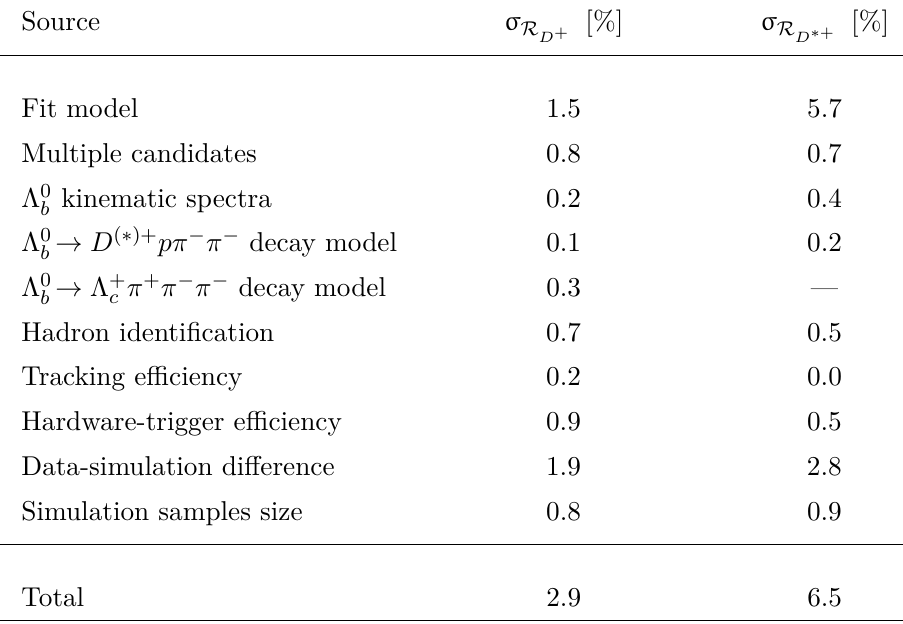
Table 2 . Relative systematic uncertainties for the ratios R obtained by summing all terms in